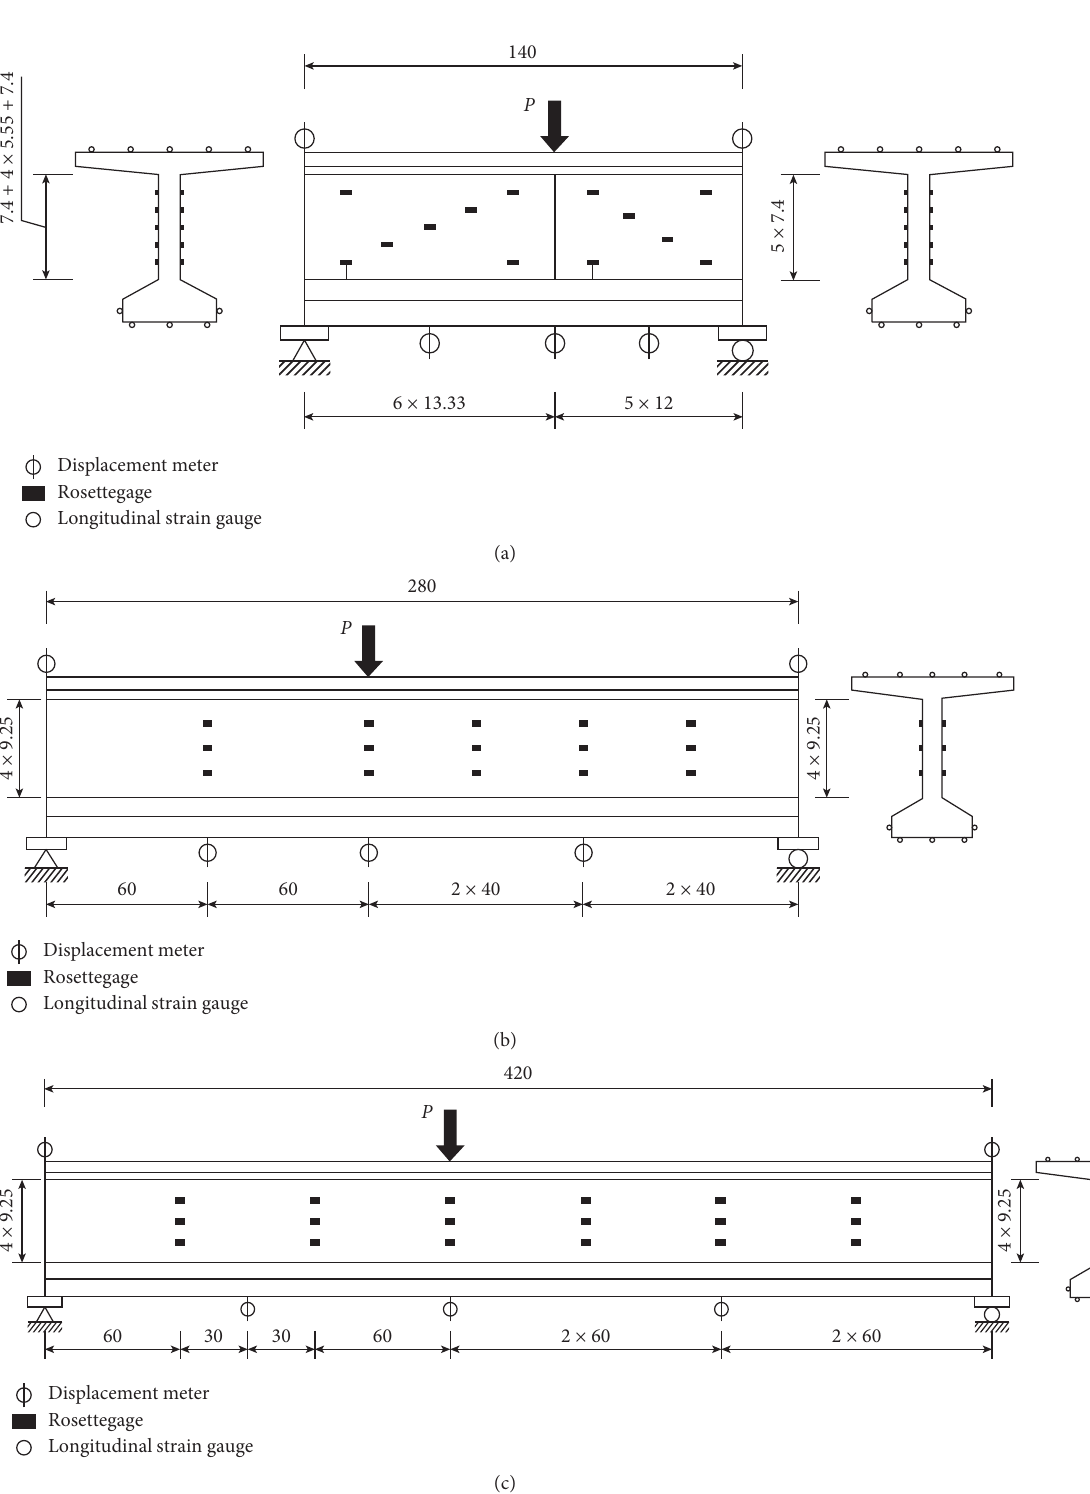
Figure 12: Positions of strain gauges. (a) L1, (b) L2, and (c)